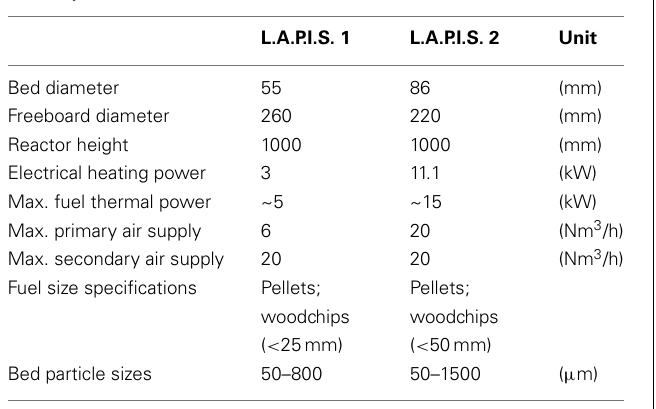
Table 2 | Properties of the L.A.P.I.S. reactors .